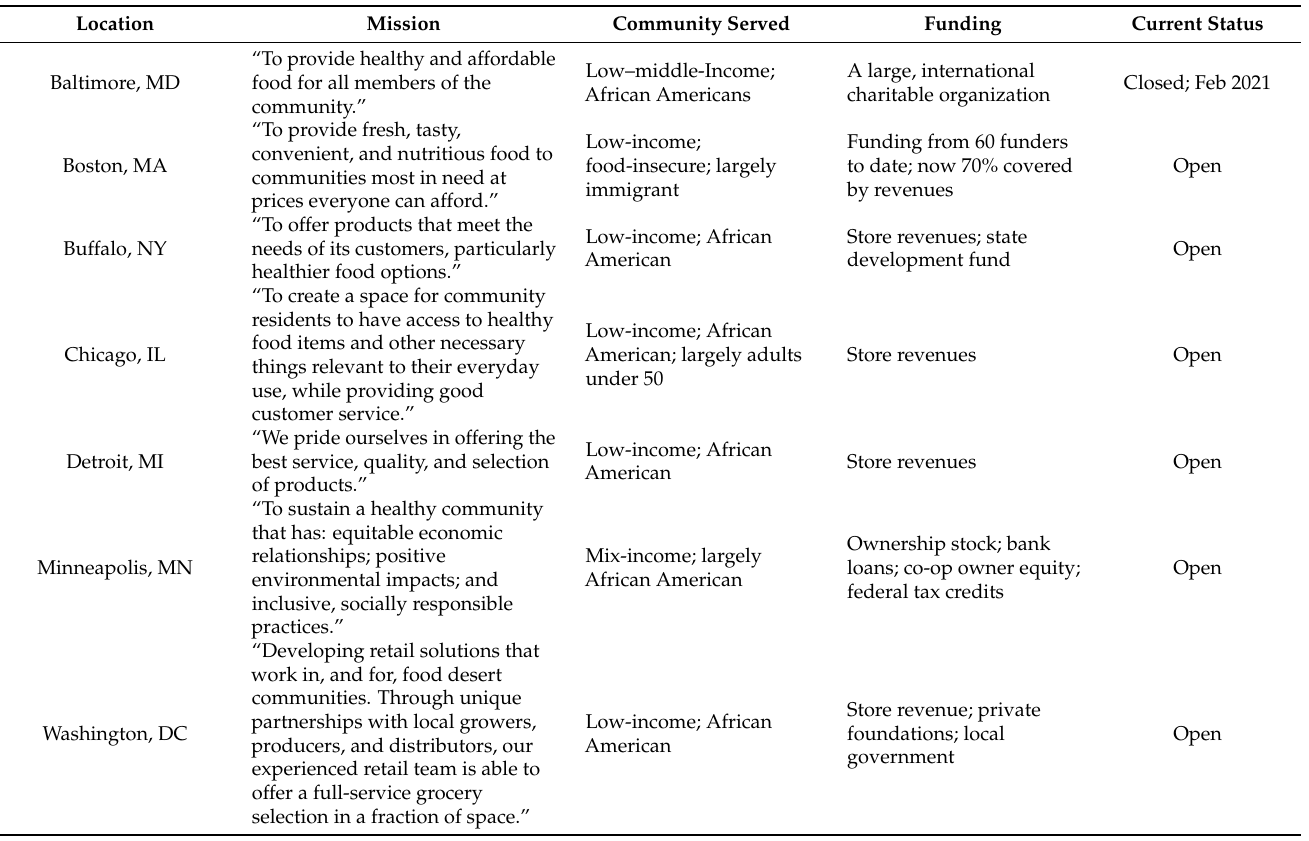
Table 2. Mission, community served, funding of case study